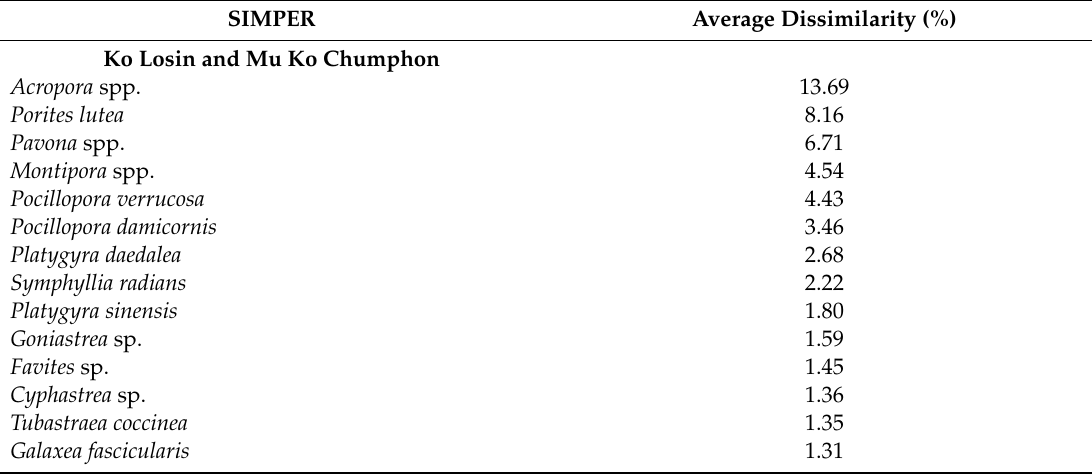
Table 2. Similarity percentage (SIMPER) analysis of benthic communities in two regions in the Gulf of Thailand.